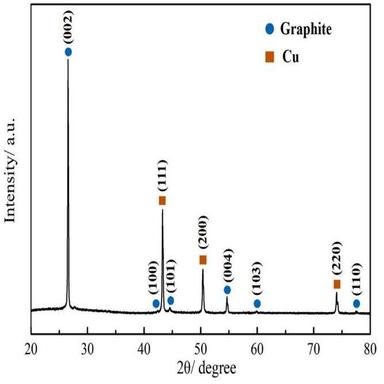
XRD of the Cu/graphite composite material.